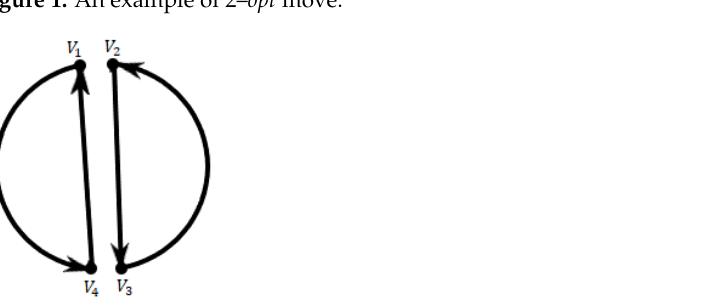
Figure 1. An example of 2– opt move.